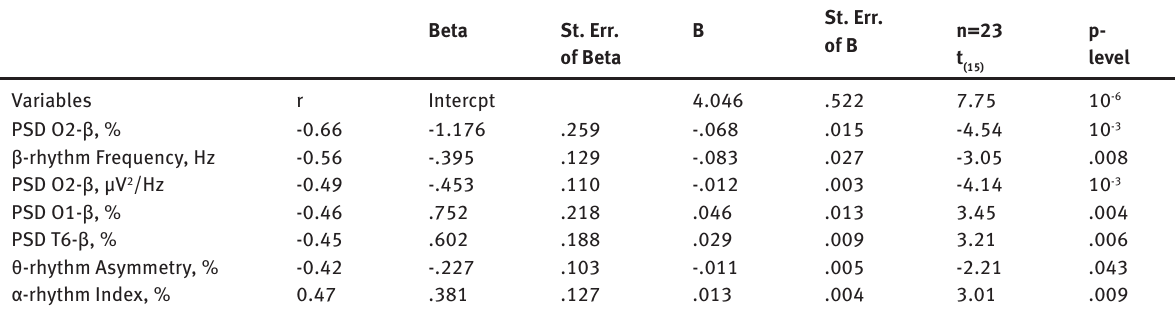
Table 4: Regression Summary for Dependent Variable: Subnuclear Neutrophiles